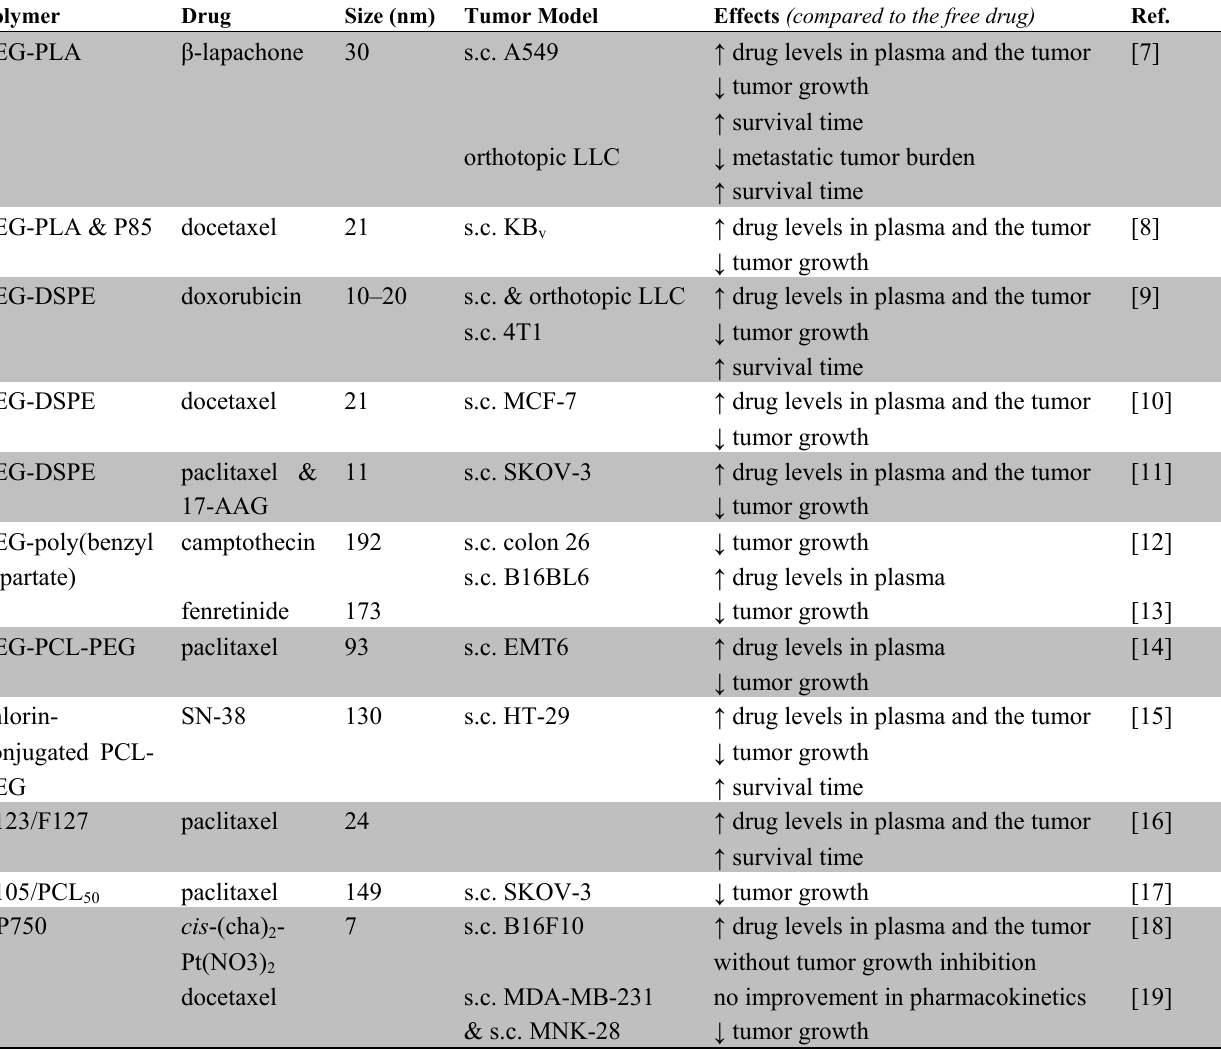
Table 1. Drug-loaded polymeric micelles can enhance the anticancer efficacy of the drugs. Polymer Drug Size (nm) Tumor Model Effects (compared to the free drug)